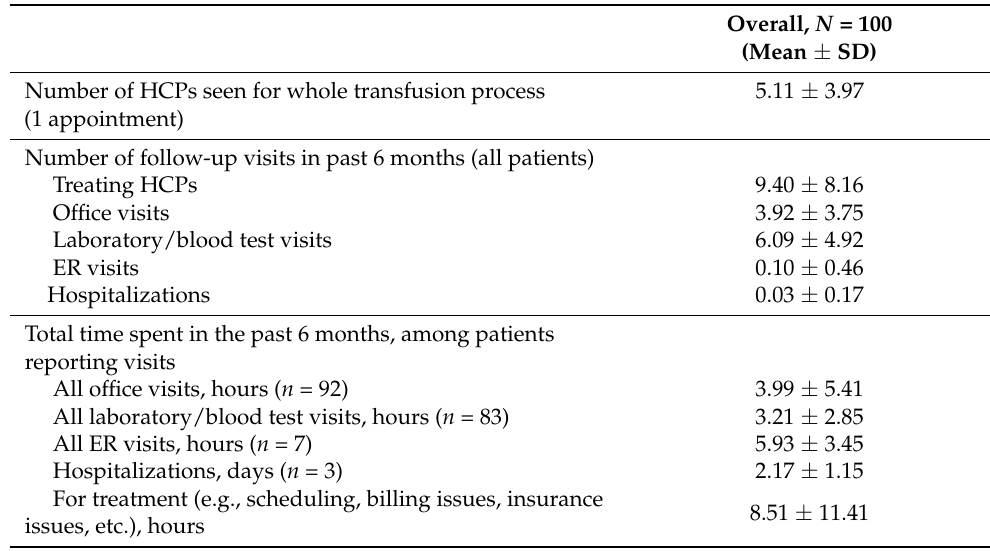
Table 3. Six-month time